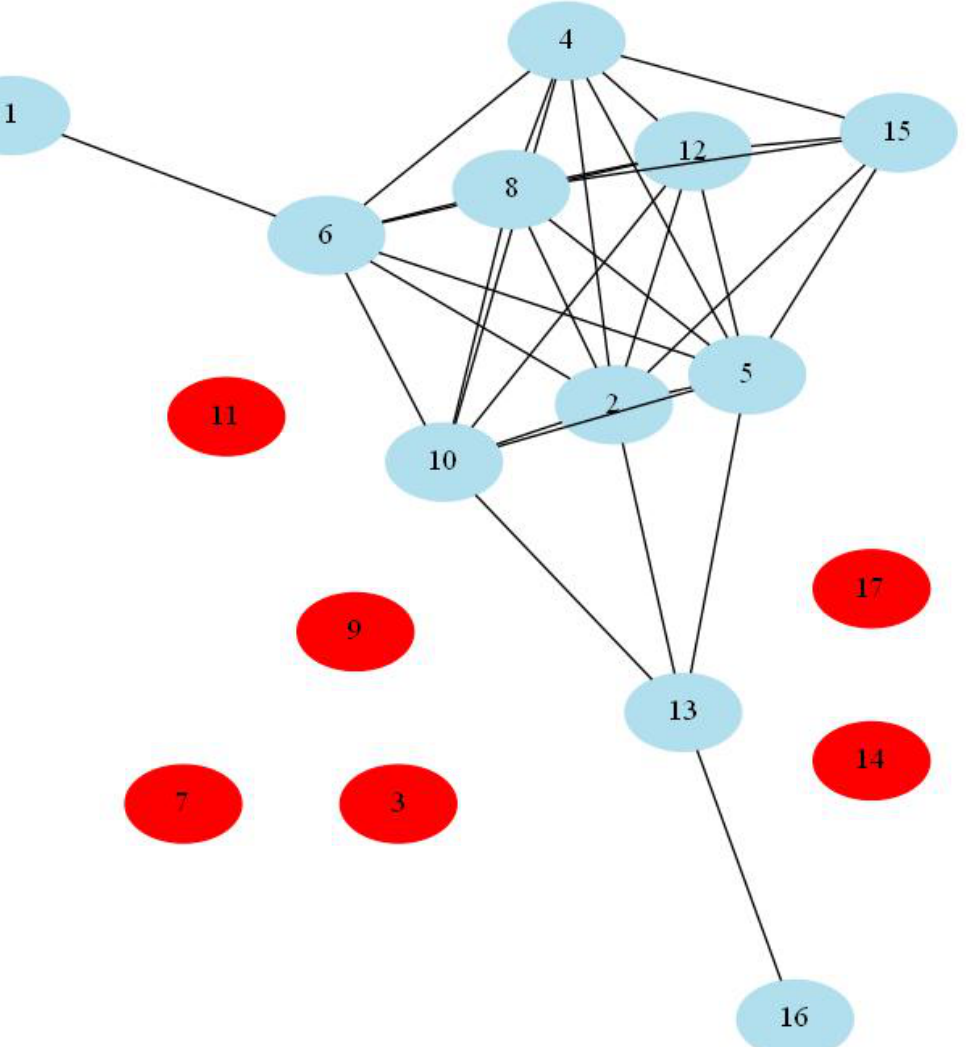
Figure 5: Graph visualization of the book chapters. Links correspond to the Euclidean distance being below a certain threshold. For convenience, the Profane storyline chapters are depicted in blue, and the V. storyline chapters in